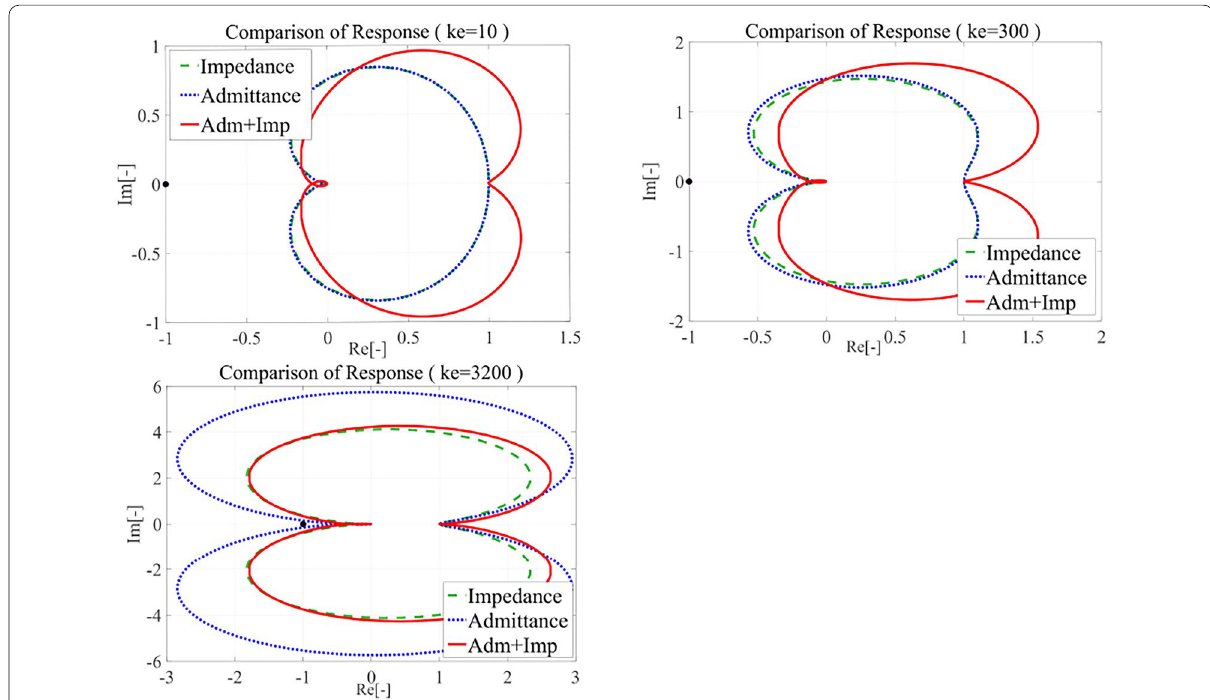
Fig. 3 Comparison of each Nyquist